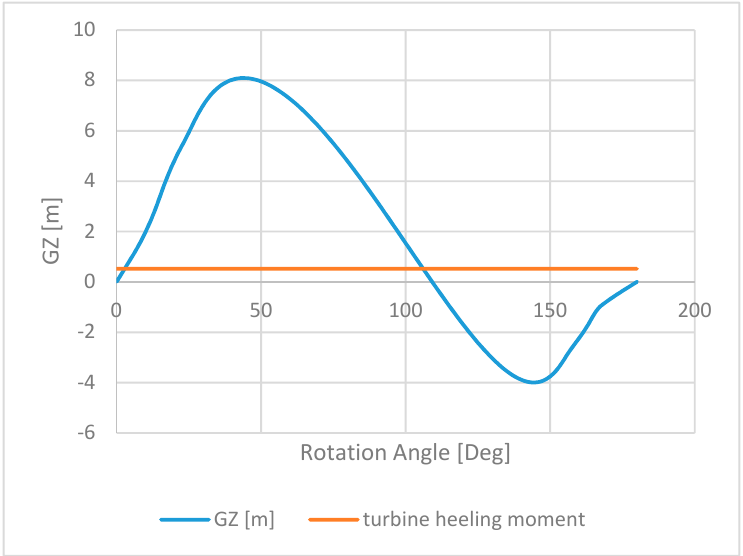
Figure 19. Righting moment arm (GZ) curve for the FDP concept.